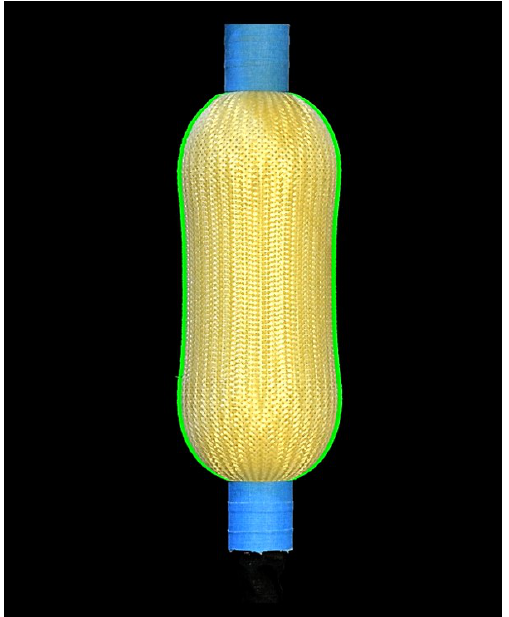
Figure 1. PAM with its braid traced along its edge (green), defining the shape profile of the